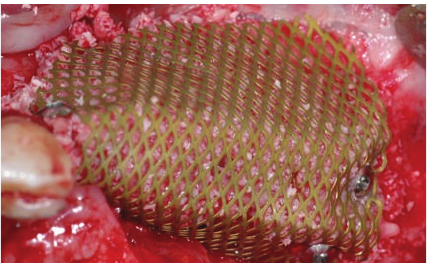
Figure 5: A titanium mesh has been placed for increasing the vertical and horizontal defect.